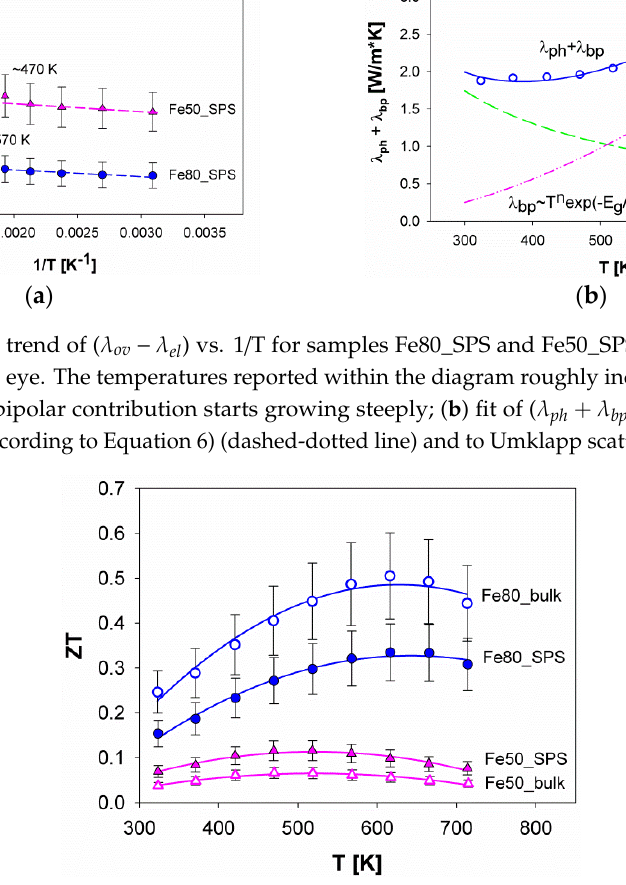
Figure 13. The trend of ZT as a function of the temperature for the samples Fe80 and Fe50. The curves fitting experimental points are second order polynomial functions.